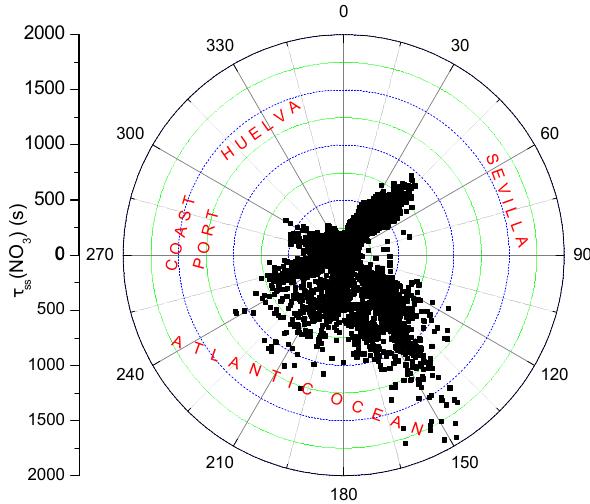
Fig. 3. Wind-direction dependence of NO 3 lifetimes (nighttime only). ∼ 50% of the airmasses encountered at night came from the Huelva sector, and were associated with very short NO 3